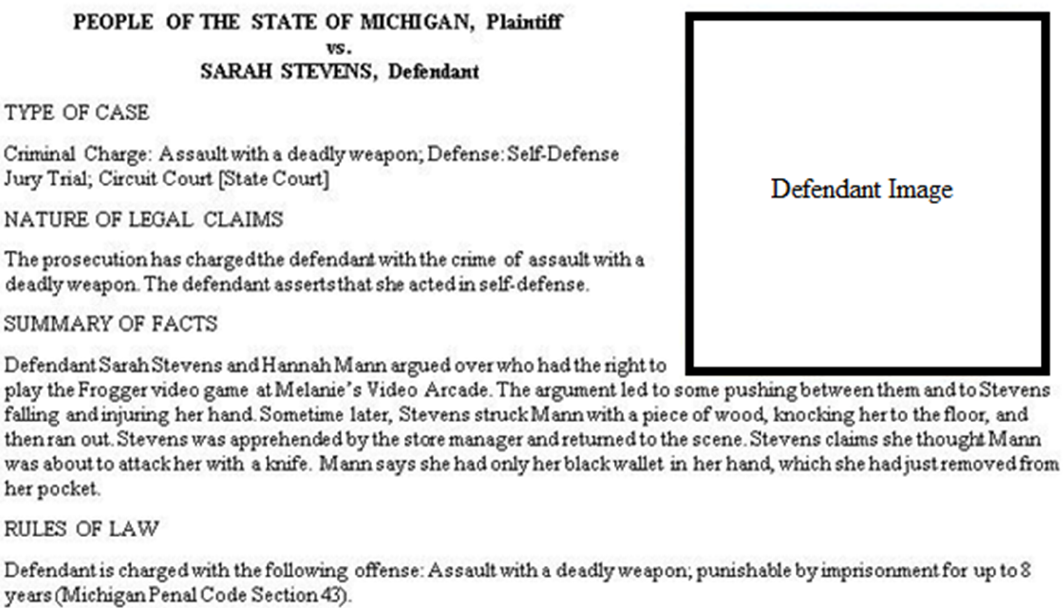
Figure A3. Third trial vignette used in Study 1.